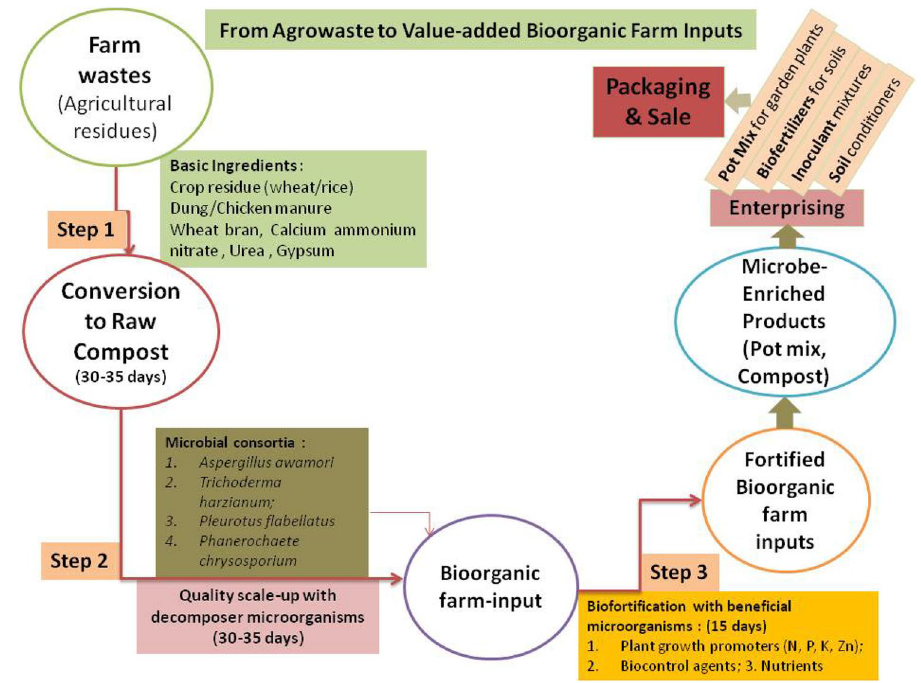
Fig. 1 Agrowaste bioconversion model based on crop residues as primary composting resource in three steps (1) agricultural waste (wheat, paddy straw, and crop leaves) is converted into raw compost in 30–35 days using different kinds of ingre- dients (C:N ratio 17:1); (2) raw compost is further decomposed in next 30 days using decom- poser microbial consortia to produce bioorganic farm inputs with C:N ratio of 30:1 and (3) fortification with beneficial microorganisms like nitrogen fixers, phosphate solubilizers, biocontrol agent(s), humic acid, micronutrients for 15 days to obtain microbe-enriched prod- ucts for direct farm